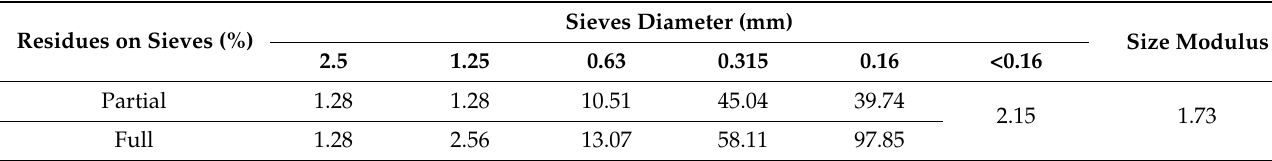
Table 2. Grain composition and modulus of sand size.